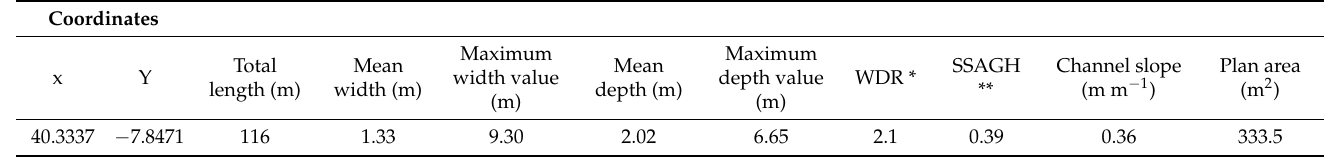
Table 1. Most important morphological characteristics of gully, sourced in